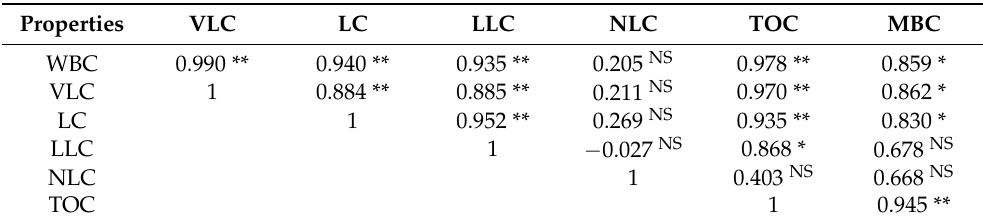
Table 3. Effect of nutrient management on relationship between C fractions. ** Correlation is significant at the 0.01 level (2-tailed); * Correlation is significant at the 0.05 level (2-tailed); NS—Non